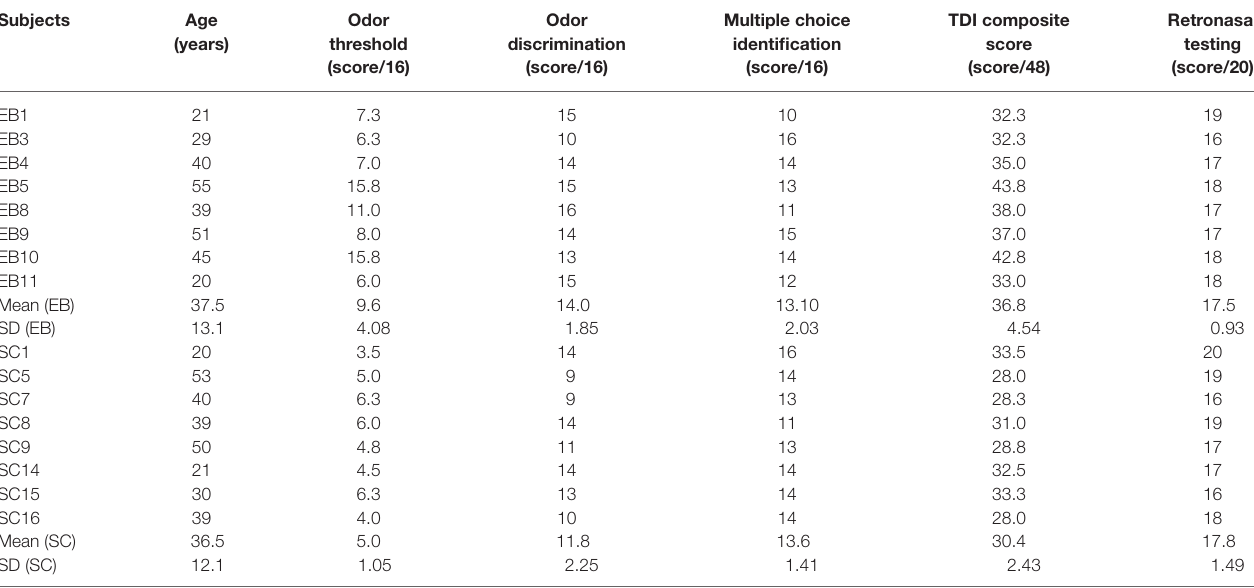
TABLE 2 | Results from behavioral experiment in blind and sighted subjects (Cuevas et al., 2010b). Subjects Age